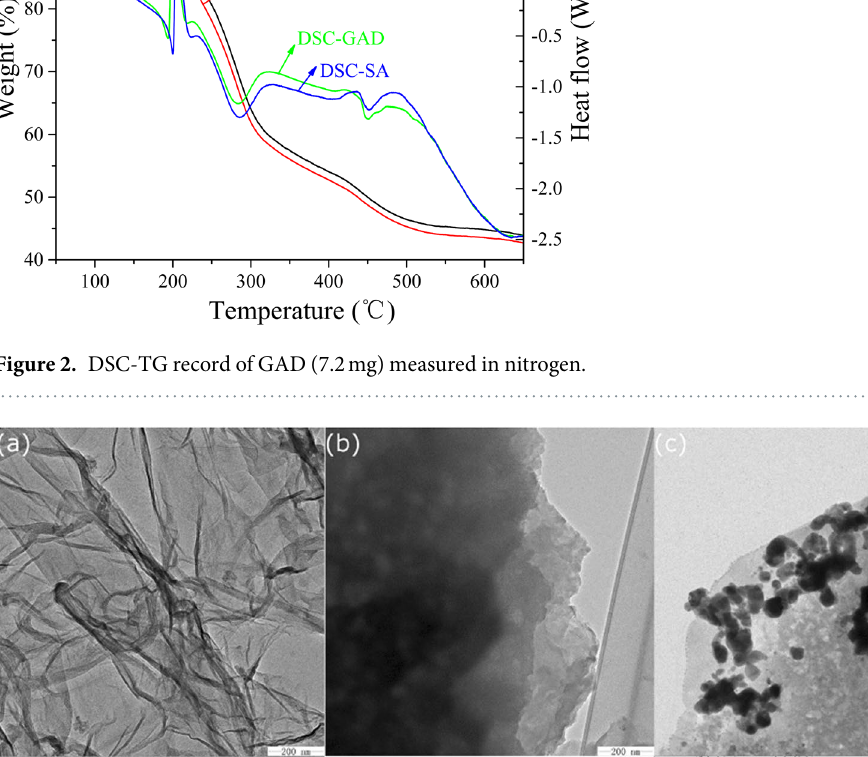
Figure 3. TEM of the ( a ) GO, the ( b ) GAD before adsorption and the ( c ) GAD after